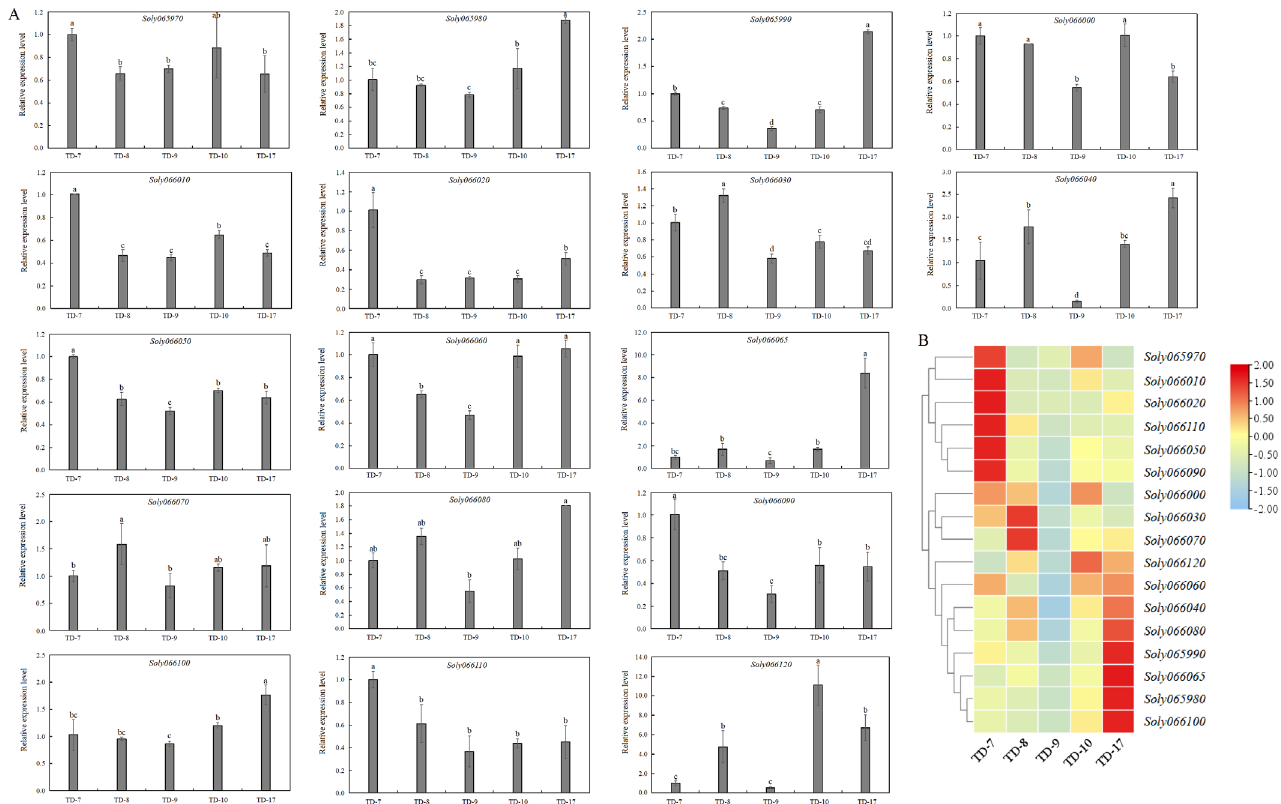
Figure 4. Expression profiles of genes within 50 kb upstream and downstream of TGS0892 in different tomato cultivars. ( A ) Expression levels of genes within 50 kb upstream and downstream of TGS0892. Different lower cases indicate the significant difference at 0.05 level; ( B ) Heat map and cluster analysis. The heat map was drawn in log2 transformed expression values. Blue and orange represent low and high expressions, respectively.